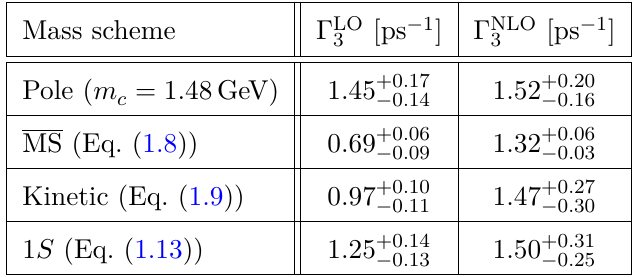
Table 5 . Numerical values of Γ LO schemes for the c -quark mass. The uncertainties are obtained by varying the renormalisation scale µ 1 between 1 GeV and 3